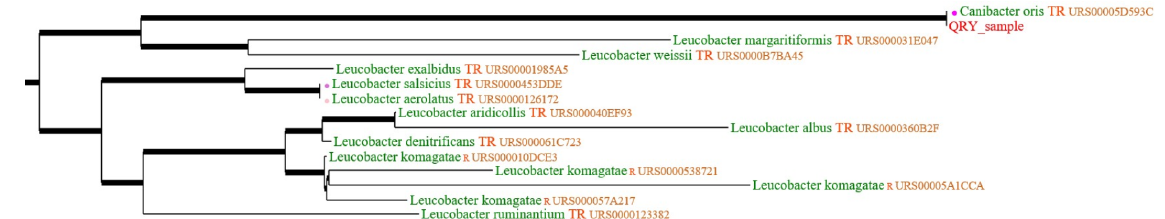
Figure 1: Dendrogramme of the genetic relationship of the isolate of Canibacter oris with the other Canibacter oris strain and with Leucobacter spp.; Quick BioInformatic Phylogeny of Prokaryotes